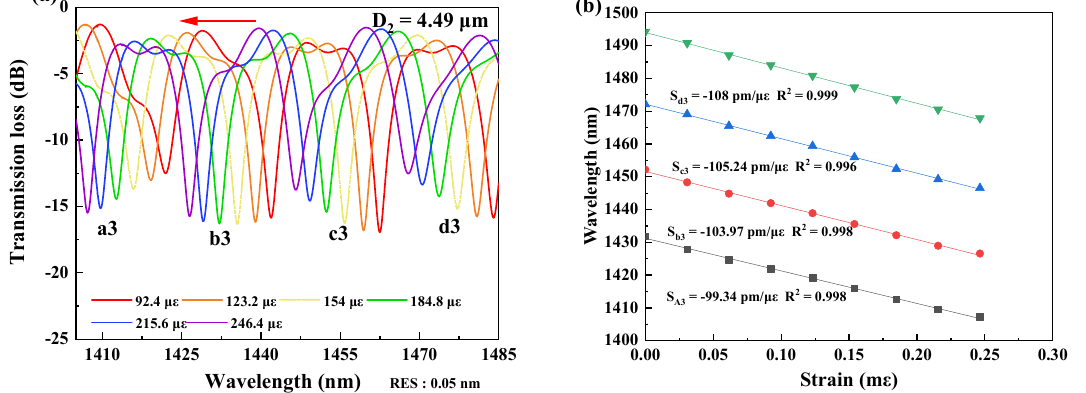
Figure 5. ( a ) Spectral responses of the interferometer with D 2 = 4.49 μm at the strain ranging over 92.4–246.4 με at 1400–1485 nm. ( b ) Linear fitting curves of the dip wavelength shifts and the coefficients of determination R 2 of linear fitting with D 2 = 4.49 μm.